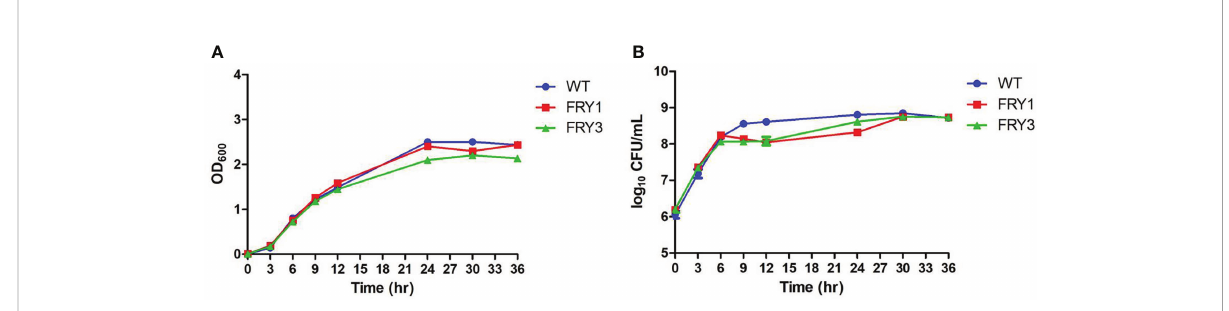
FIGURE 5 The growth kinetics of D srf mutants were slightly decreased. (A) Growth curves were determined based on the OD 600 values. (B) Growth curves were determined based on the viable cell counts (CFU/ml). The strains were 10-fold diluted and spread on LB agar plates. Total colony numbers were counted after 1 day growth at 37°C.